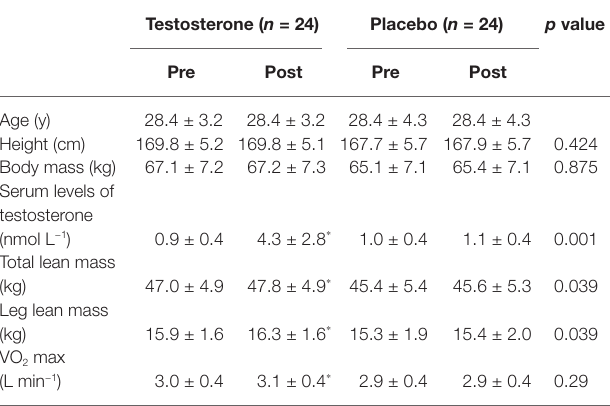
TABLE 1 | Subject characteristics, hormone concentrations, lean mass, and VO 2 max pre and post